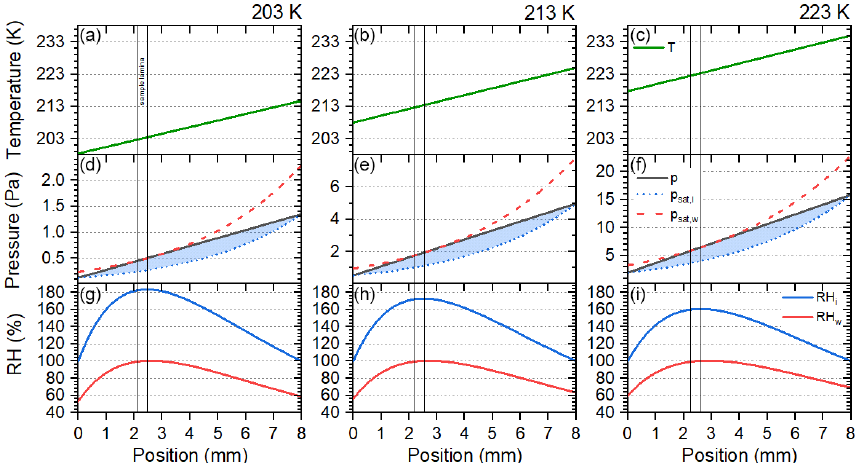
Figure 1. Linear temperature (a, b, c) and water vapour partial pressure (d, e, f) gradients between the wall plates of SPIN at 203, 213, and 223K lamina temperature and RH w = 100%. Water vapour partial pressure ( p ) is compared to the saturation vapour pressure over water ( p sat , w ) and ice ( p sat , i ), calculated according to Murphy and Koop (2005). Ice super-saturated conditions are indicated as shaded areas. The resulting profiles of relative humidity with respect to ice (RH i ) and with respect to water (RH w ) are given in the third row (g, h, i) . Sample position is indicated by vertical lines.